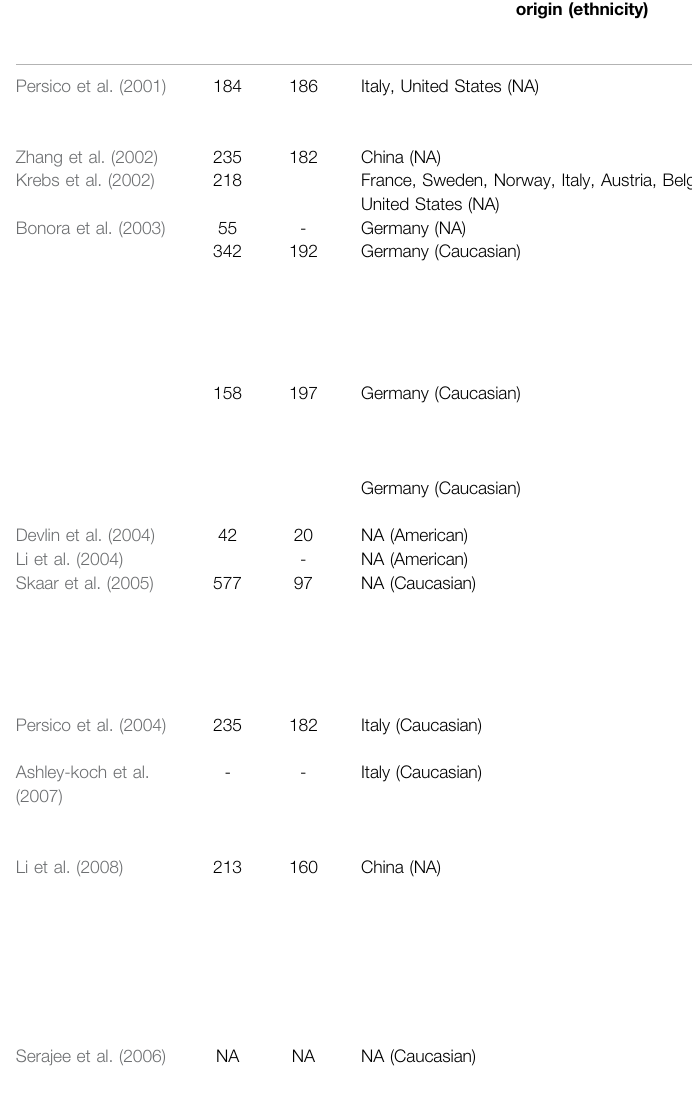
TABLE 1 | Summary of the positive and negative RELN -ASD correlations in the published cohorts.